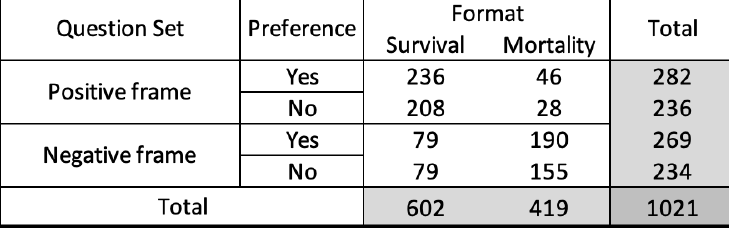
Figure 12. Respondent totals by preference.